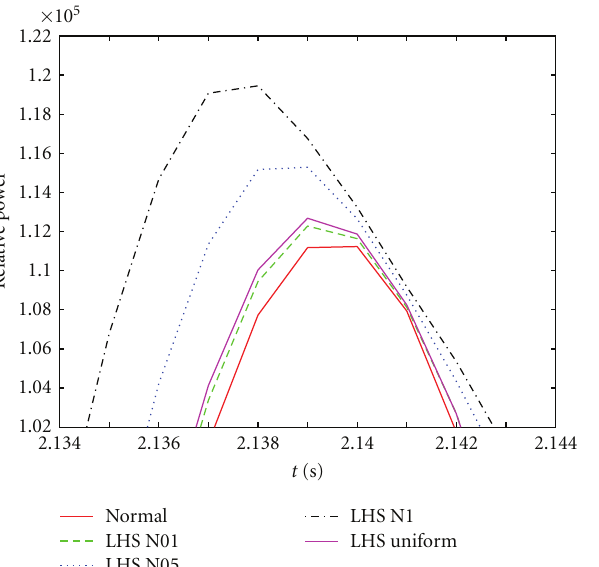
Figure 14: Power upper tolerance limit (UTL) for LHS sampling method.